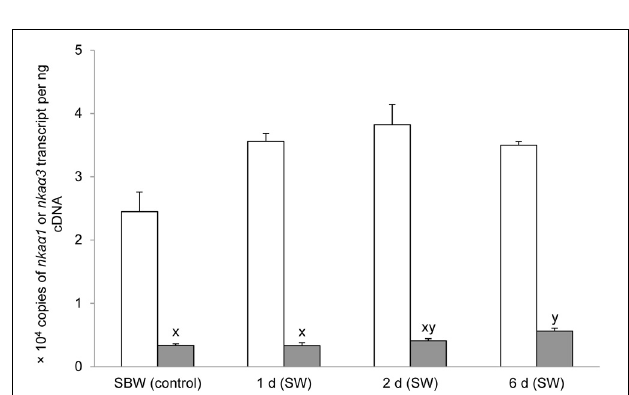
FIGURE 8 | Effects of exposure to seawater on Na + /K + -ATPase ( nka ) α 1 and nka α 3 mRNA expression. Absolute quantification (copies of transcript per ng cDNA) of nka α 1 ( (cid:2) ) and nka α 3 ( (cid:3) ) in gills of Periophthalmodon schlosseri kept in slightly brackish water (SBW; salinity 3) for 2 weeks (control) or after 1, 2, or 6 days of transfer from SBW to seawater (SW; salinity 30). Results represent mean + s.e.m. ( N = 4). Means not sharing the same letter are significantly different ( P < 0 .